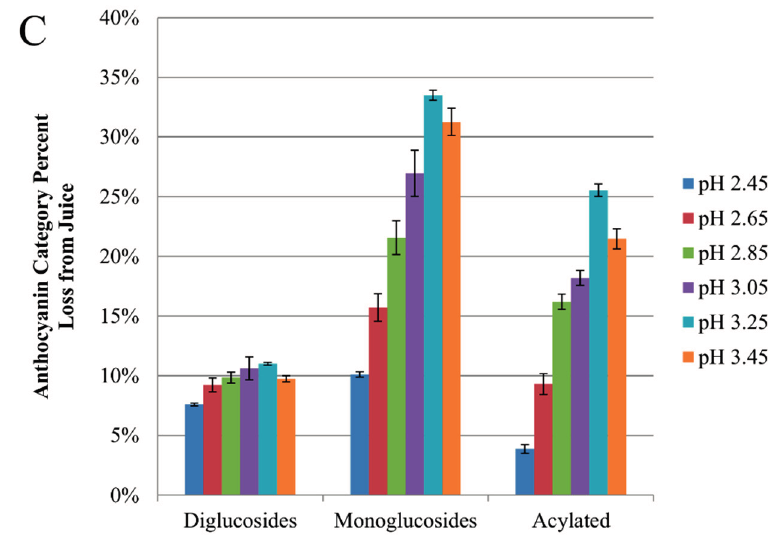
Figure 5. Effects of pH on ( A ) the mass fraction (%w/w) of individual anthocyanins in KHT crystals; ( B ) the percent loss ((Original − Final)/Original ×100%) of individual anthocyanin species lost from Concord juice; and ( C ) the percent loss of anthocyanin classes lost from Concord